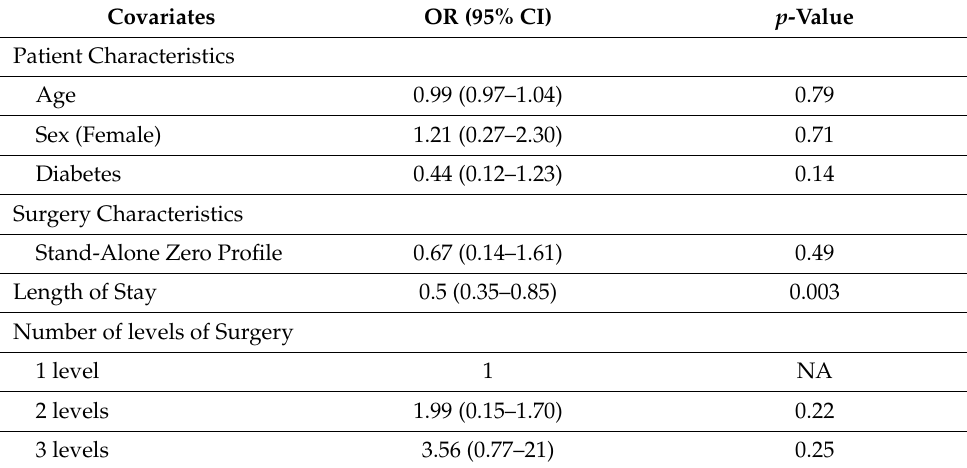
Table 4. Multivariable